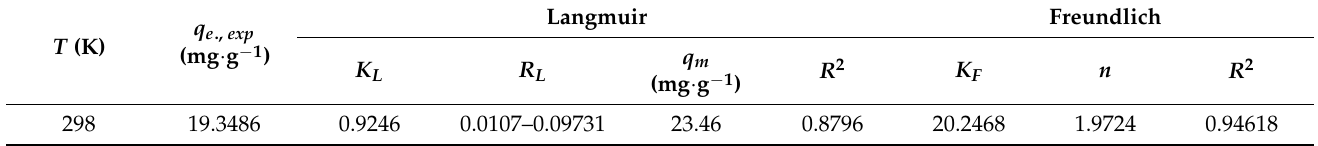
Table 5. Adsorption isotherms parameters of MO on